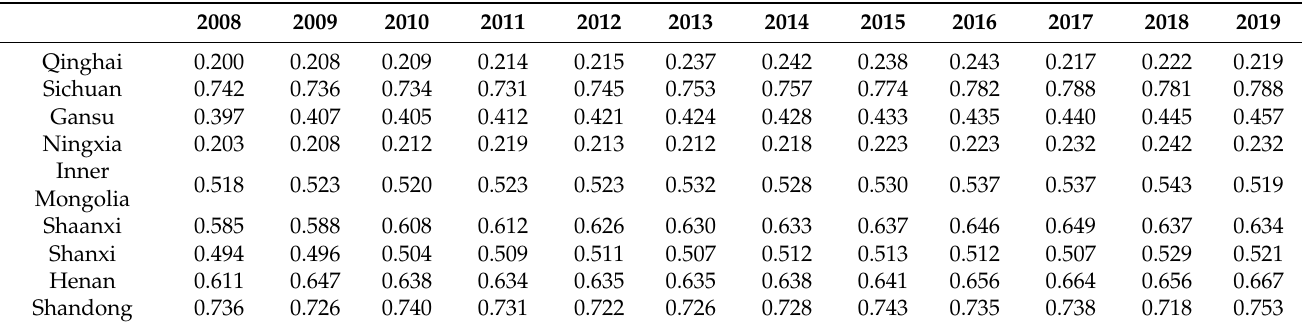
Table 4. Time Evolution of Tourism, Ecological Environment and Public Service CCD in the Yellow River Basin from 2008 to